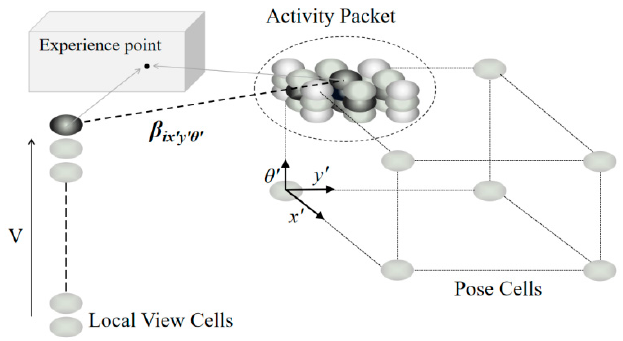
Figure 2. Local view cells and pose